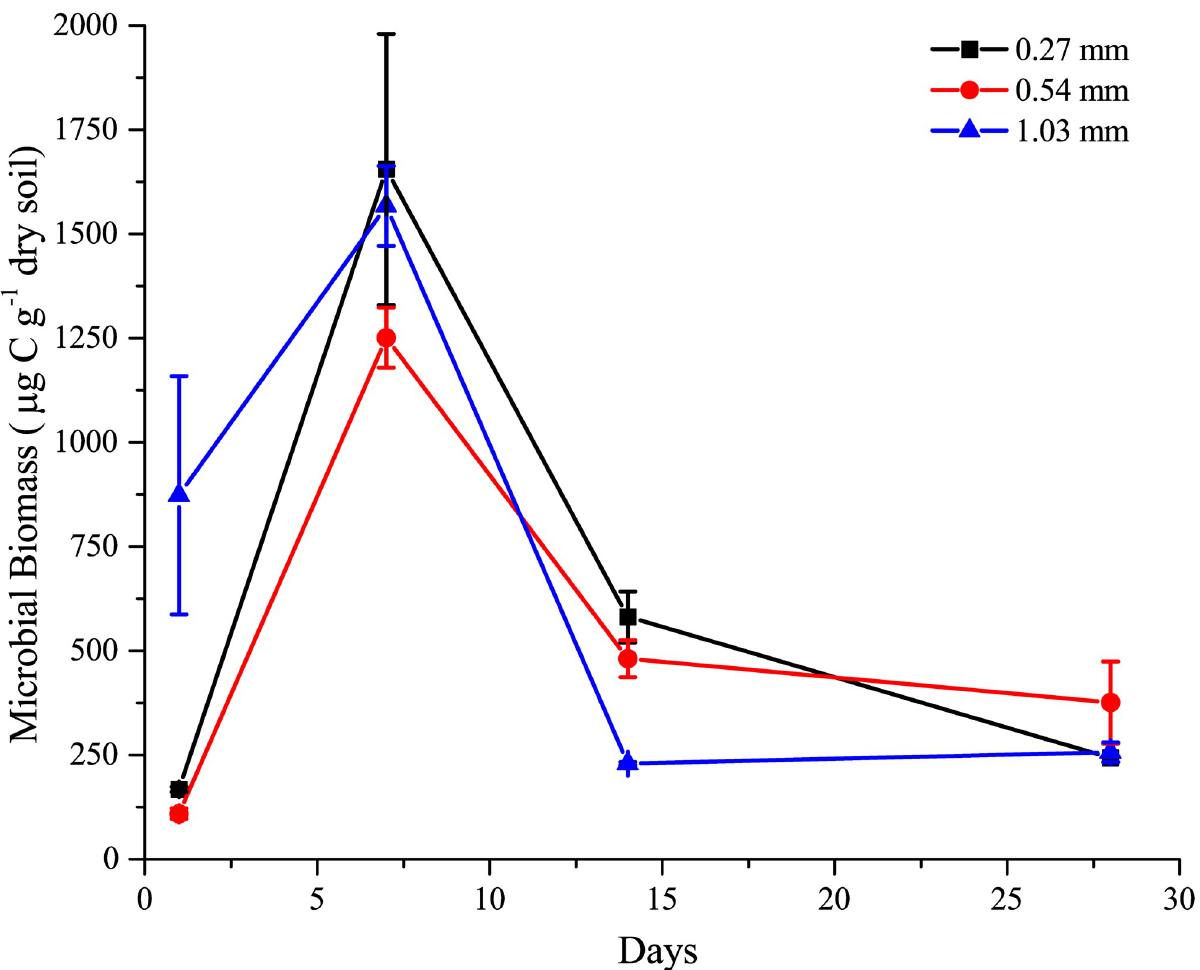
Fig 6. Soil microbial biomass in soil amended with SRF of various